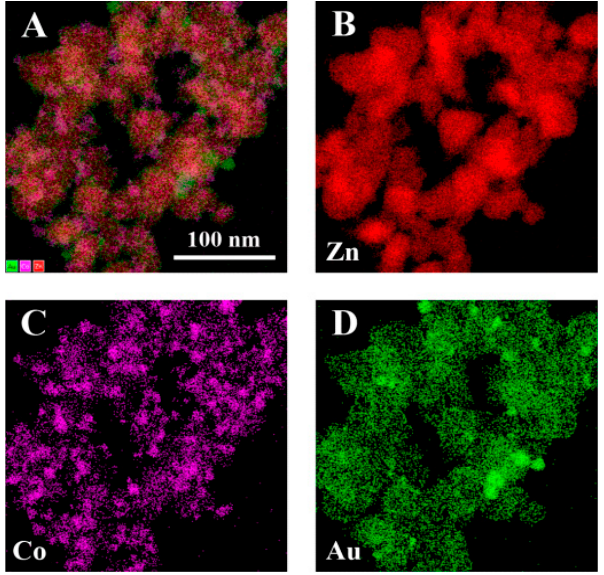
Figure 4. EDX elemental mappings of Co 400 -ZnO/Au: The overlaid image ( A ) from ( B − D ), and Zn ( B ), Co ( C ), and Au ( D ).